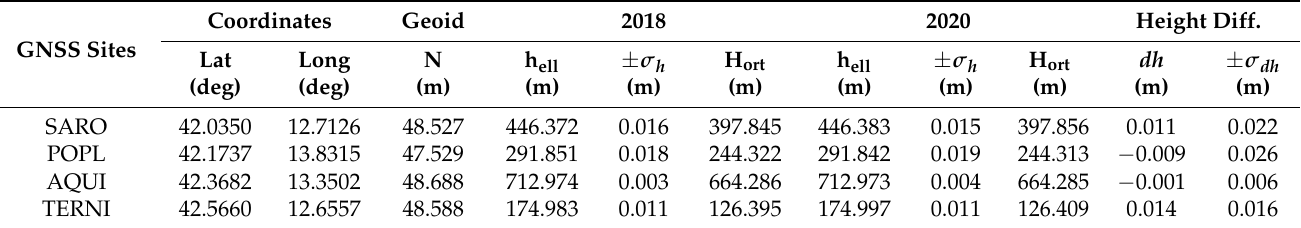
Table 2. GNSS sites: coordinates, geoidal undulations, measured ellipsoidal heights, with accuracies and orthometric heights of the 2018 and 2020 surveys. Coordinates GNSS Sites